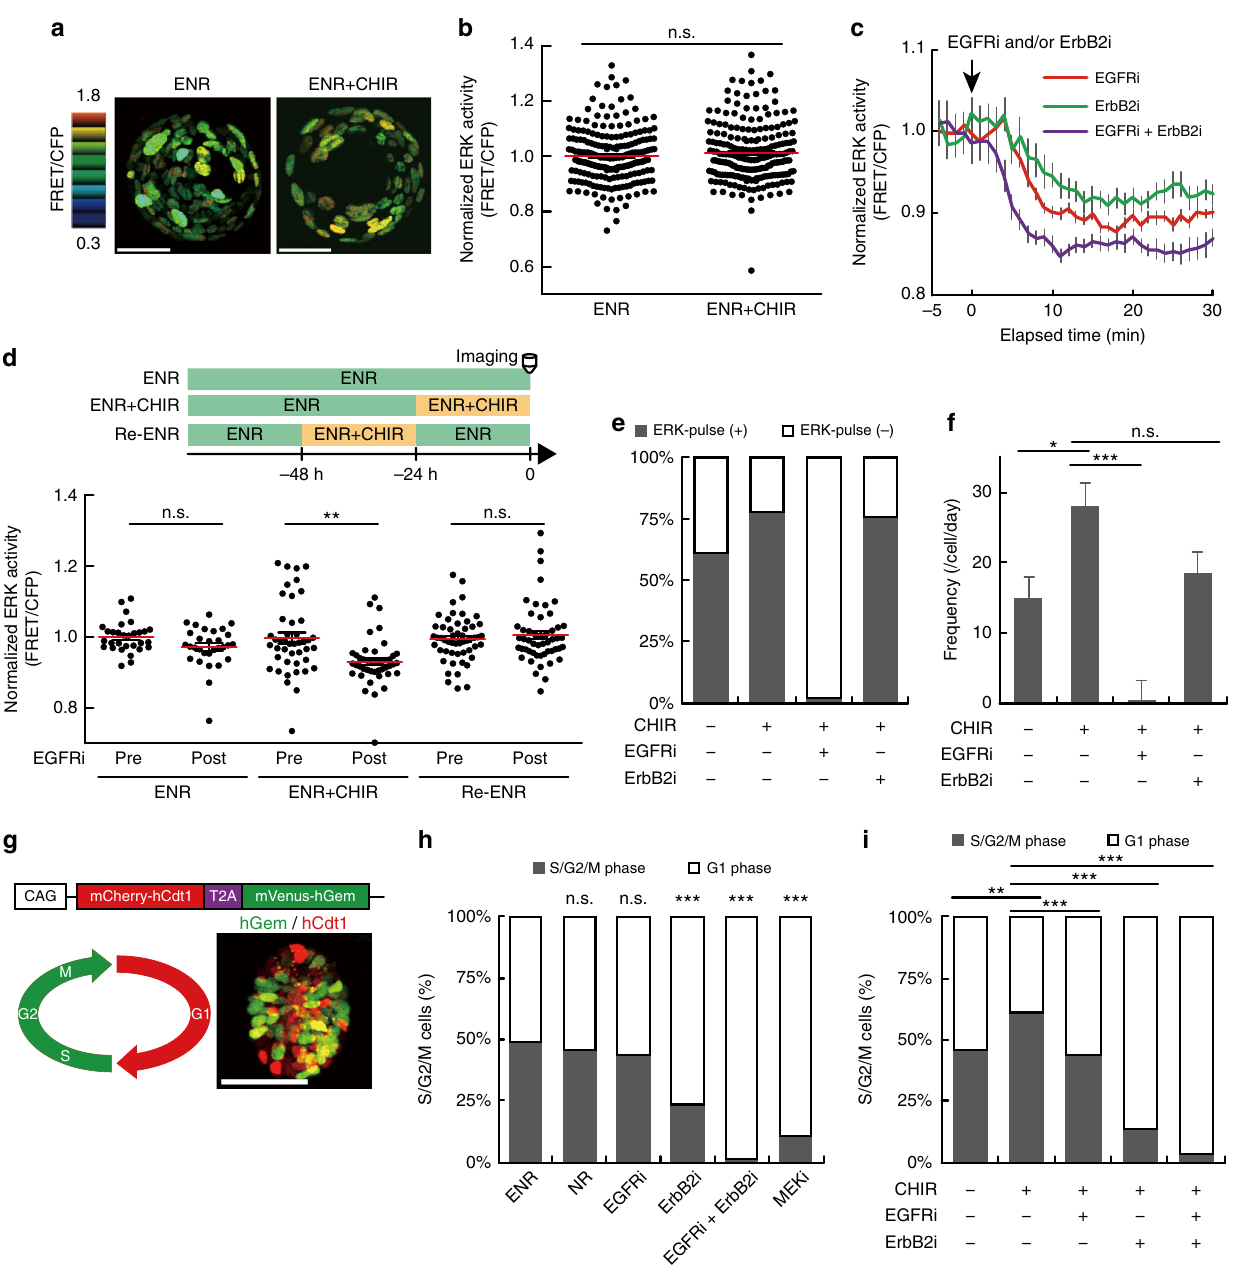
Fig. 6 Pharmacological activation of Wnt signalling promotes cell proliferation by augmenting EGFR signalling. a Representative images and b quanti fi cation of ERK activity in organoids treated with or without CHIR99021 (5 μ M) for 24 h ( n = 210 and 213 cells (from the left), from three organoids). c Time courses of ERK activity in organoids treated with CHIR99021 for 24 h and then treated with EGFRi (PD153035), and/or ErbB2i (CP-724714) ( n = 45, 29, and 29 cells from the left). d Quanti fi cation of ERK activity before (Pre) and after (Post) EGFRi treatment (bottom) ( n = 30, 44, and 53 cells from the left). Organoids cultured in ENR, ENR + CHIR, or ENR + CHIR99021 for 24 h and then in ENR for another 24 h (Re-ENR) were treated with EGFRi (top). e , f Quanti fi cation of ERK activity pulses in organoids treated with CHIR99021 for 24 h and then with EGFRi and/or ErbB2i for 90 min during imaging. The proportion of cells with ERK activity pulses (ERK-pulse + ) ( e ), and the frequency of the pulses ( f ) under each condition ( n = 36, 47, 47, and 25 cells from the left). g Schematic structure of Fucci2a (top), cell cycle diagram marked with corresponding fl uorescence (bottom left), and the representative image of organoid expressing Fucci2a (bottom right). h , i Proportion of cells in the S/G2/M phases in the Fucci2a organoids. h Organoids were cultured for 24 h in ENR, EGF-de fi cient medium (NR), or ENR supplemented with EGFRi ErbB2i, and/or a MEK inhibitor (MEKi) ( n = 158, 264, 400, 359, 423, and 243 cells (from the left), from more than four organoids). i Organoids treated with CHIR99021 for 24 h were subsequently treated with EGFRi, and/or ErbB2i for another 24 h ( n = 156, 1062, 461, 220, and 234 cells (from the left), from more than four organoids). Scale bars, 50 µ m. Red lines represent mean. Error bars represent s.e.m. Mann – Whitney U -test ( b , d ), Steel – Dwass test ( f ), and χ 2 test with BH procedure ( h , i ) were used for comparison.* P < 0.05, ** P < 0.001, *** P < 0.0001, n.s., not signi fi